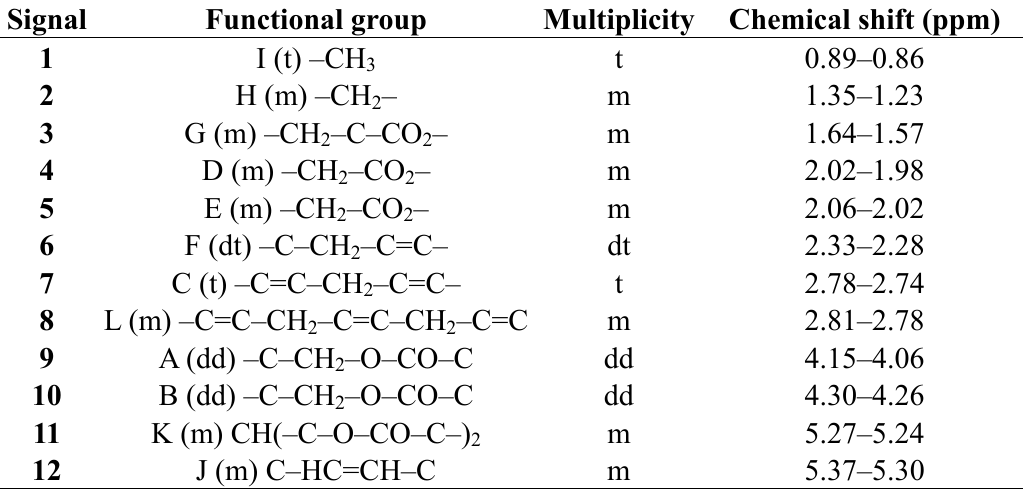
Table 2. Assignment of the signals of Camellia japonica oil 1 H-NMR spectra (750 MHz for 1